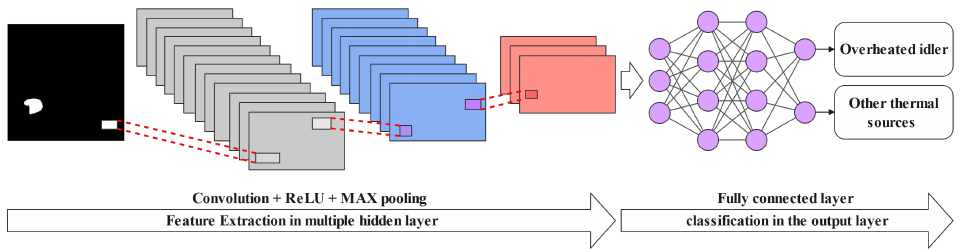
Figure 8. Simplified flowcharts of binary classification procedure.